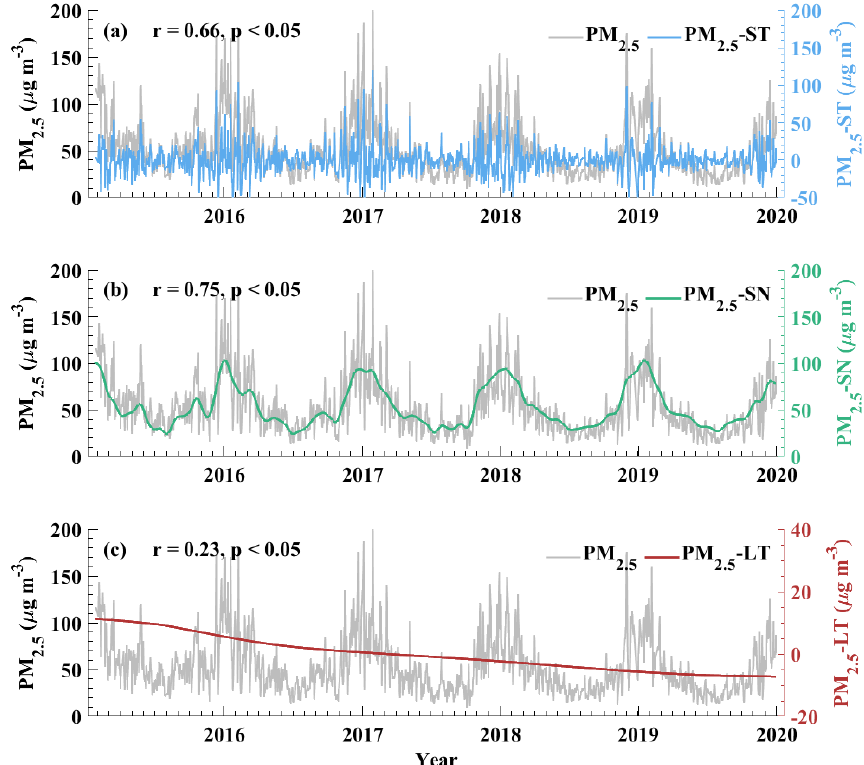
Figure 3. The relations of regional averages of (a) short-term (PM 2 . 5 -ST), (b) seasonal (PM 2 . 5 -SN) and (c) long-term (PM 2 . 5 -LT) compo- nents with the observed daily PM 2 . 5 concentrations (PM 2 . 5 ) over the THB from 2015 to